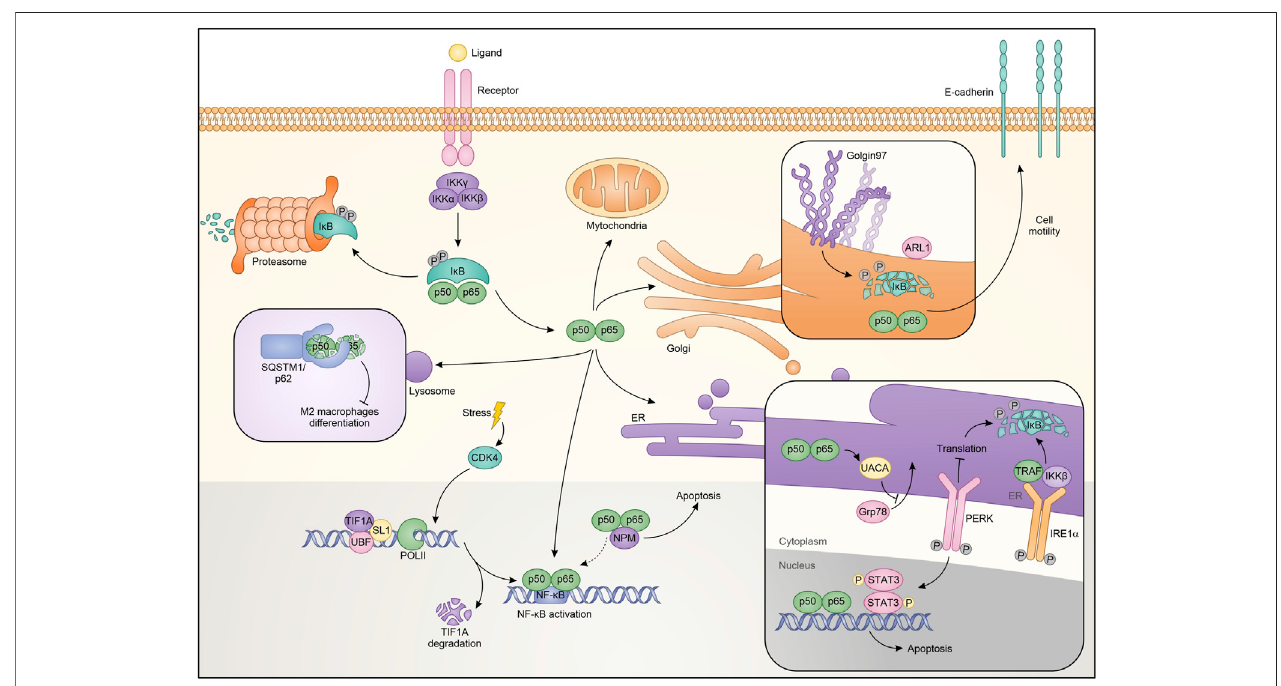
FIGURE 2 | Schematic representation of NF- κ B localization and roles in the different cellular compartments.